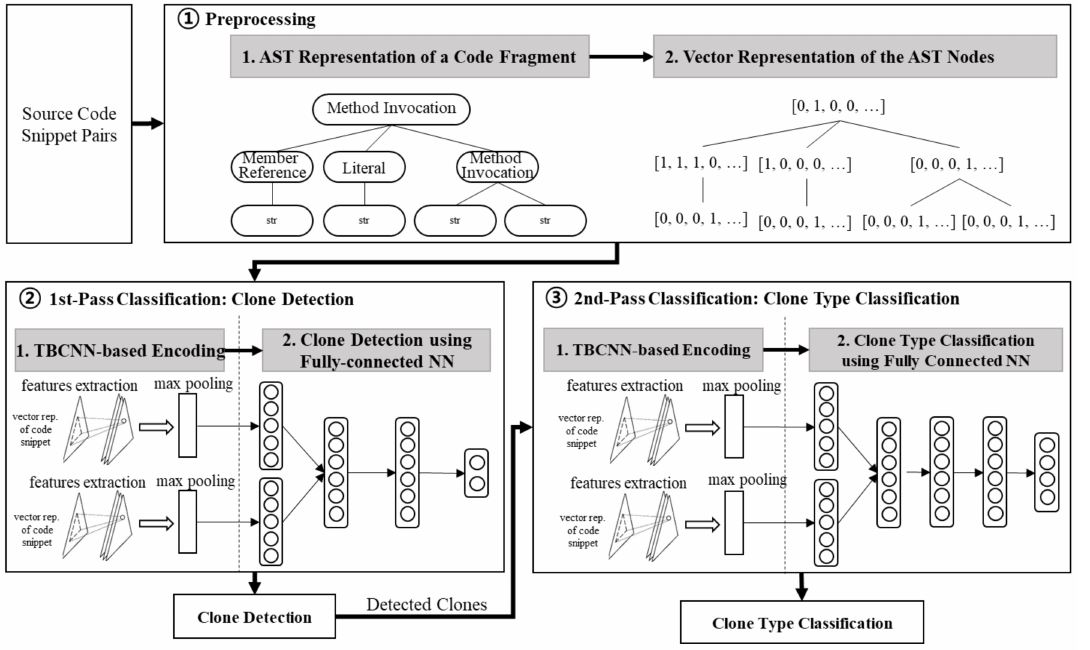
Figure 2. Steps of the TBCNN-based two-pass clone detection and clone type